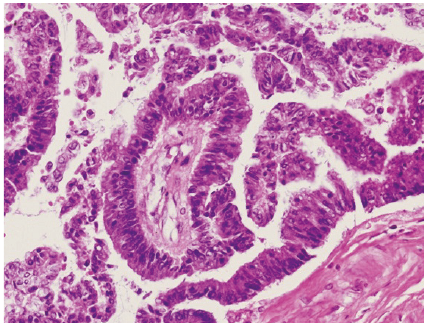
Figure 4: Histological examination showed low-grade malignant mucinous